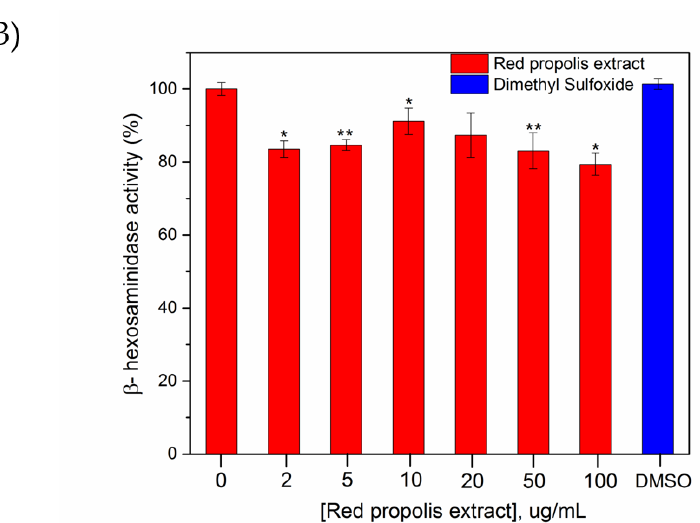
Figure 6. ( A ) E ff ect of red propolis extract (RPE), quercetin and ketotifen fumarate on the release of the beta-hexosaminidase enzyme, from mast cells stimulated by antigen. Anti-DNP IgE-sensitized RBL-2H3 cells were treated with red propolis extract, quercetin or ketotifen fumarate at the indicated concentrations, followed by antigen (DNP-BSA) stimulation and addition of the substrate metilumbeliferil-N-acetil- β -D-glucosaminida (MUG). Released β -hexosaminidase was determined as described in the materials and methods section. Data are expressed as mean ± SD of three independent experiments. ( B ) E ff ect of RPE on the β -hexosaminidase activity. Enzyme activity was quantitated by fluorescence measurements of methyl-umbelliferone after cell supernatants were incubated with RPE (1–100 µ g mL − 1 ) and 1.2 mmol L − 1 MUG solution. One-way ANOVA, followed by Dunnett’s test, used for both assay indicates statistical significance of * p < 0.05, ** p < 0.01 and *** p < 0.001 in comparison to the placebo samples.